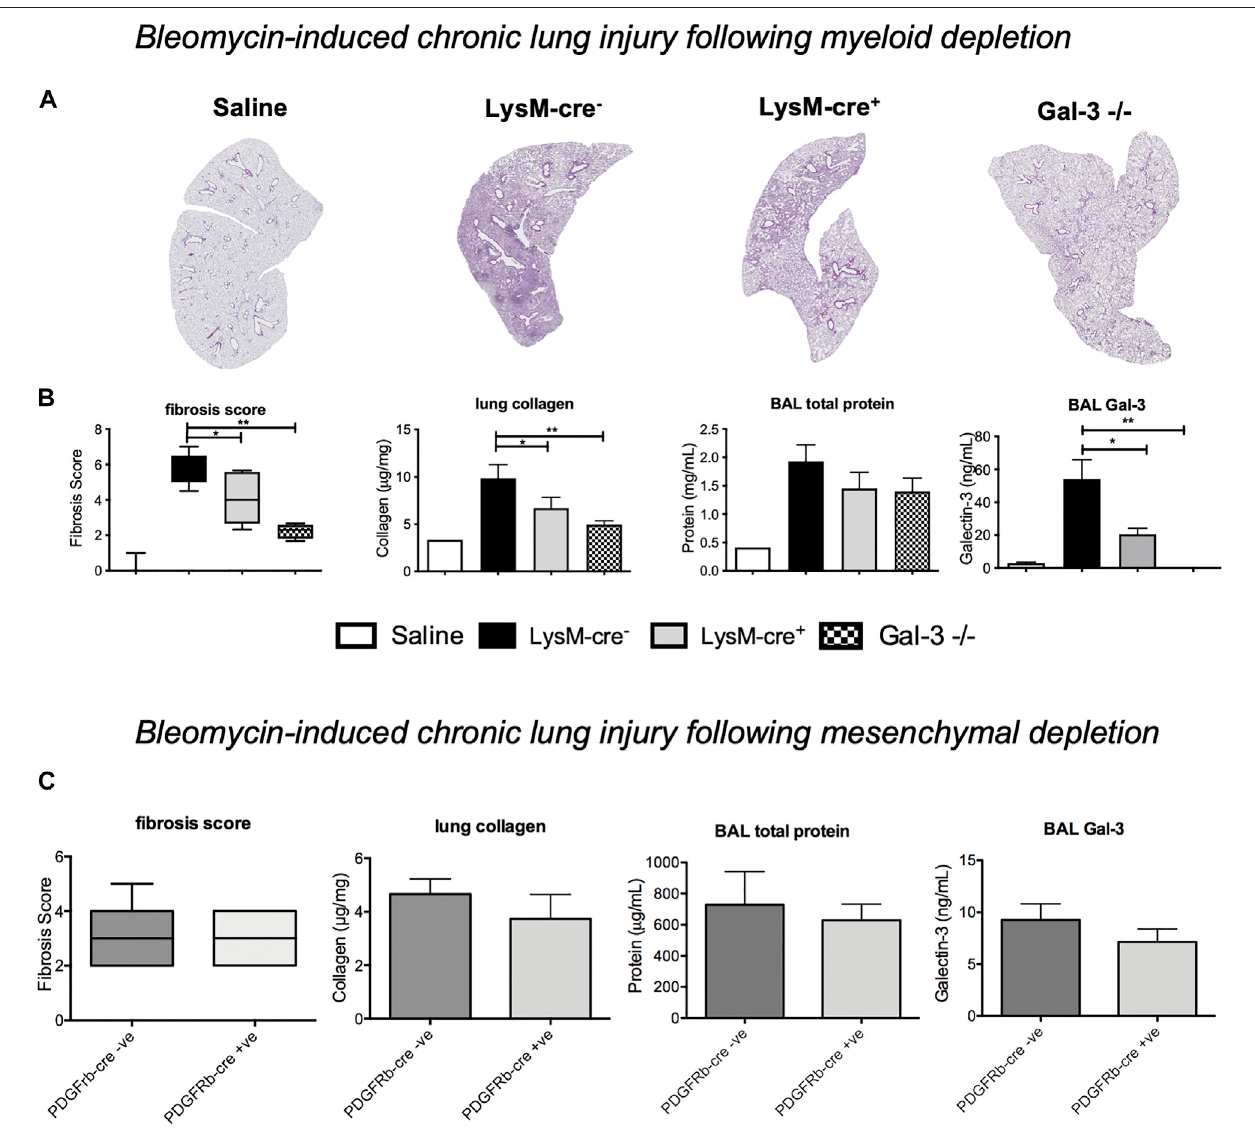
FIGURE 4 | - Effect of myeloid cell and myo fi broblast Gal-3 depletion on bleomycin induced fi brosis . Bleomycin was administered i. t. to LysM-cre - , LysM-cre + , Pdgfrb-cre -- Pdgfrb-cre + mice or global Gal-3 − / − mice. Lungs were retrieved on day 21. (A) Lung sections from LysM-cre +/- and Gal-3 − / − mice 21 days after bleomycin administration,stainedwithMasson ’ strichrome (purple) toidentify fi brosis. (B) Fibrosis score,lungcollagen,BAL totalprotein andBALGal-3 from LysM-cre +/- and Gal- 3 − / − mice 21 days after bleomycin administration. (C) Effect of mesenchymal cell Gal-3 depletion 21 days after bleomycin administration. Data represented as mean ± SEM. Analysed via 1-way ANOVA (B) or student ’ s t -test (C) ( n (cid:1) 4-5, ** p < 0.01, *** p < 0.001).